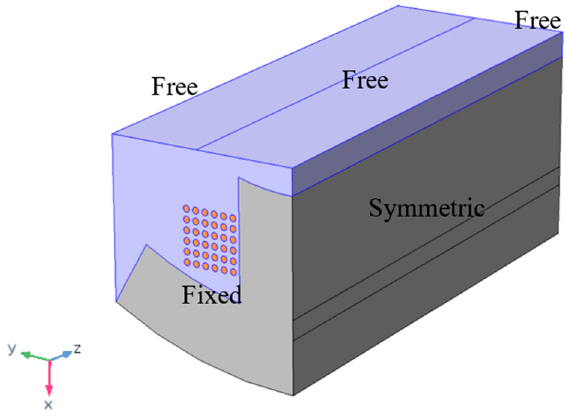
Figure 20. The geometry used in the numerical model used for validation.